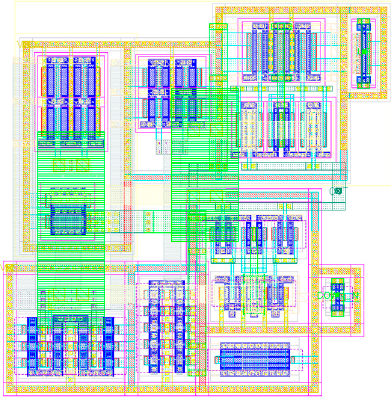
Figure 15. Charge Pump’s layout.